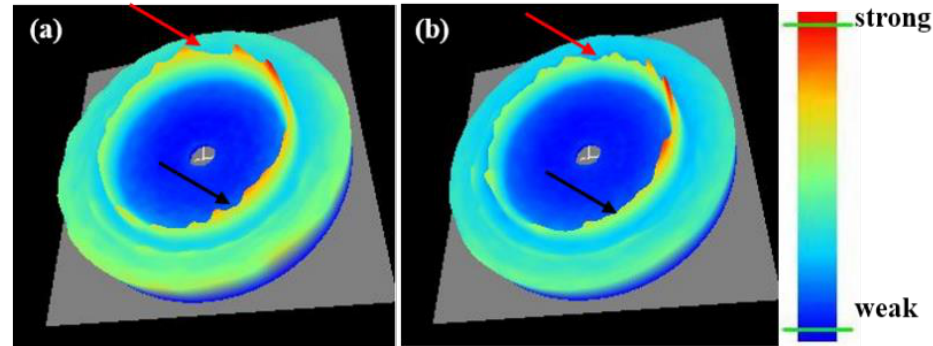
Figure 9. Change of Debye ring ( a ) before and ( b ) after LNB.